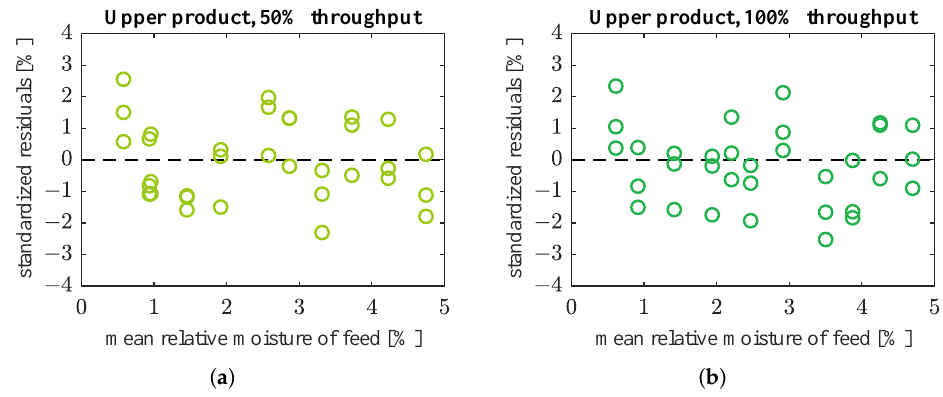
Figure 11. Residual plots for straight lines with saturation from Figure 10: ( a ) upper product, 50% of nominal throughput; ( b ) upper product, 100% of nominal throughput. Data for lower product are not plotted as they are identical to Figure